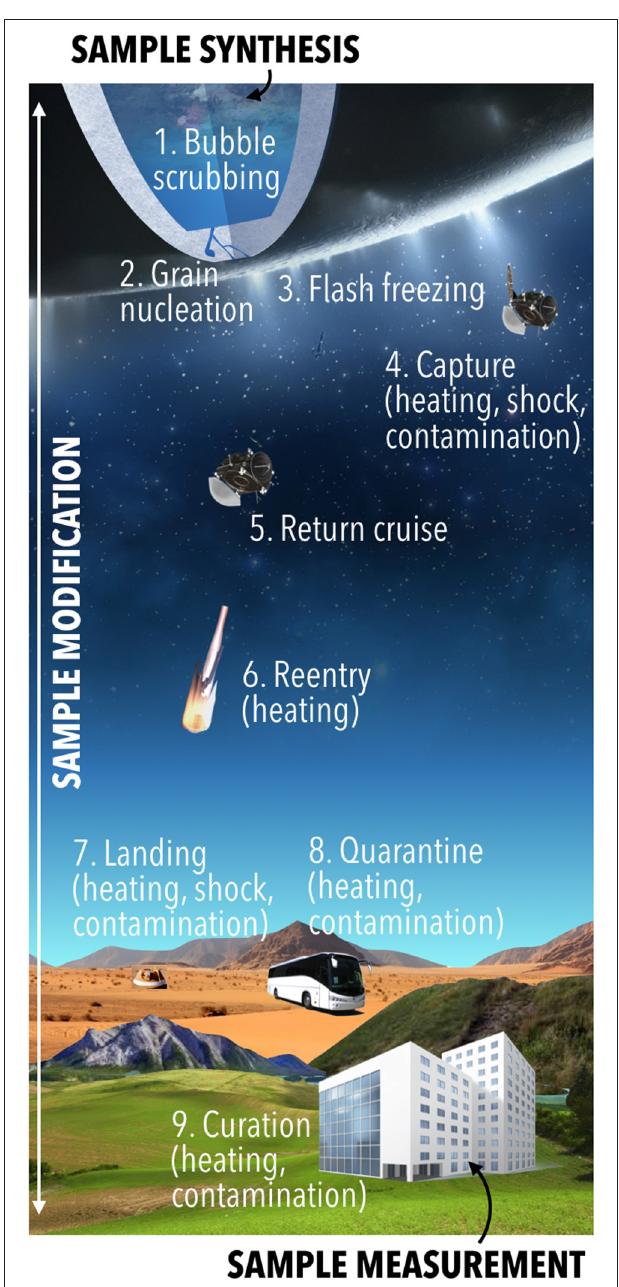
FIGURE 4 | Stages of sample alteration between synthesis and measurement. This includes alteration steps due to ascent and ejection, which cannot be controlled, and steps from collection onward, for which sample alteration can be minimized. The sample can be further altered by the measurement method. Elements of this image from NASA-JPL/Caltech (public domain) and PNGImg, used under a CC BY-NC 4.0 license.